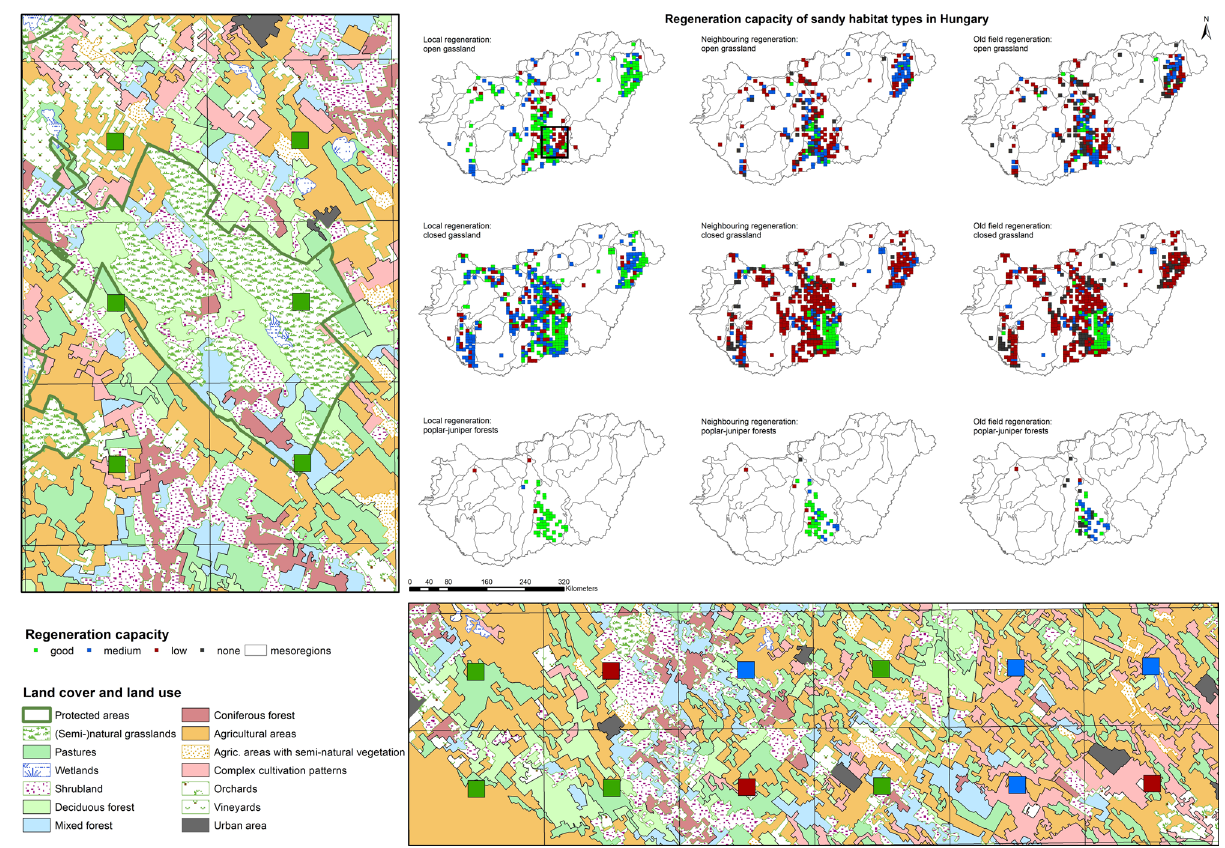
Fig. 1 Local, neighboring, and old- fi eld regeneration capacity of sandy habitat types in Hungary. Countrywide distribution of local, neighboring, and old- fi eld regeneration capacity of open sand steppes ( n = 271), closed sand steppes ( n = 498), and poplar-juniper sand dune forests and thickets ( n = 52) and two sample areas showing typical land use (based on Hungarian Habitat Mapping Database 68 – 70 and European CORINE Land Cover 2006 database 72 ) in the sandy regions of Hungary.